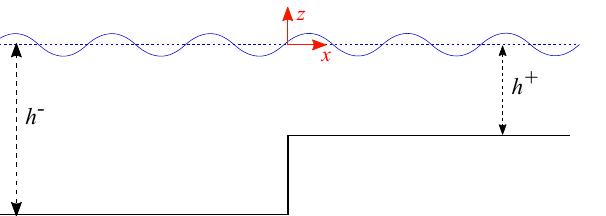
Figure 1. Scheme of the propagation problem of a nonlinear wave over a submerged rectangular obstacle. The incident wave comes from the left